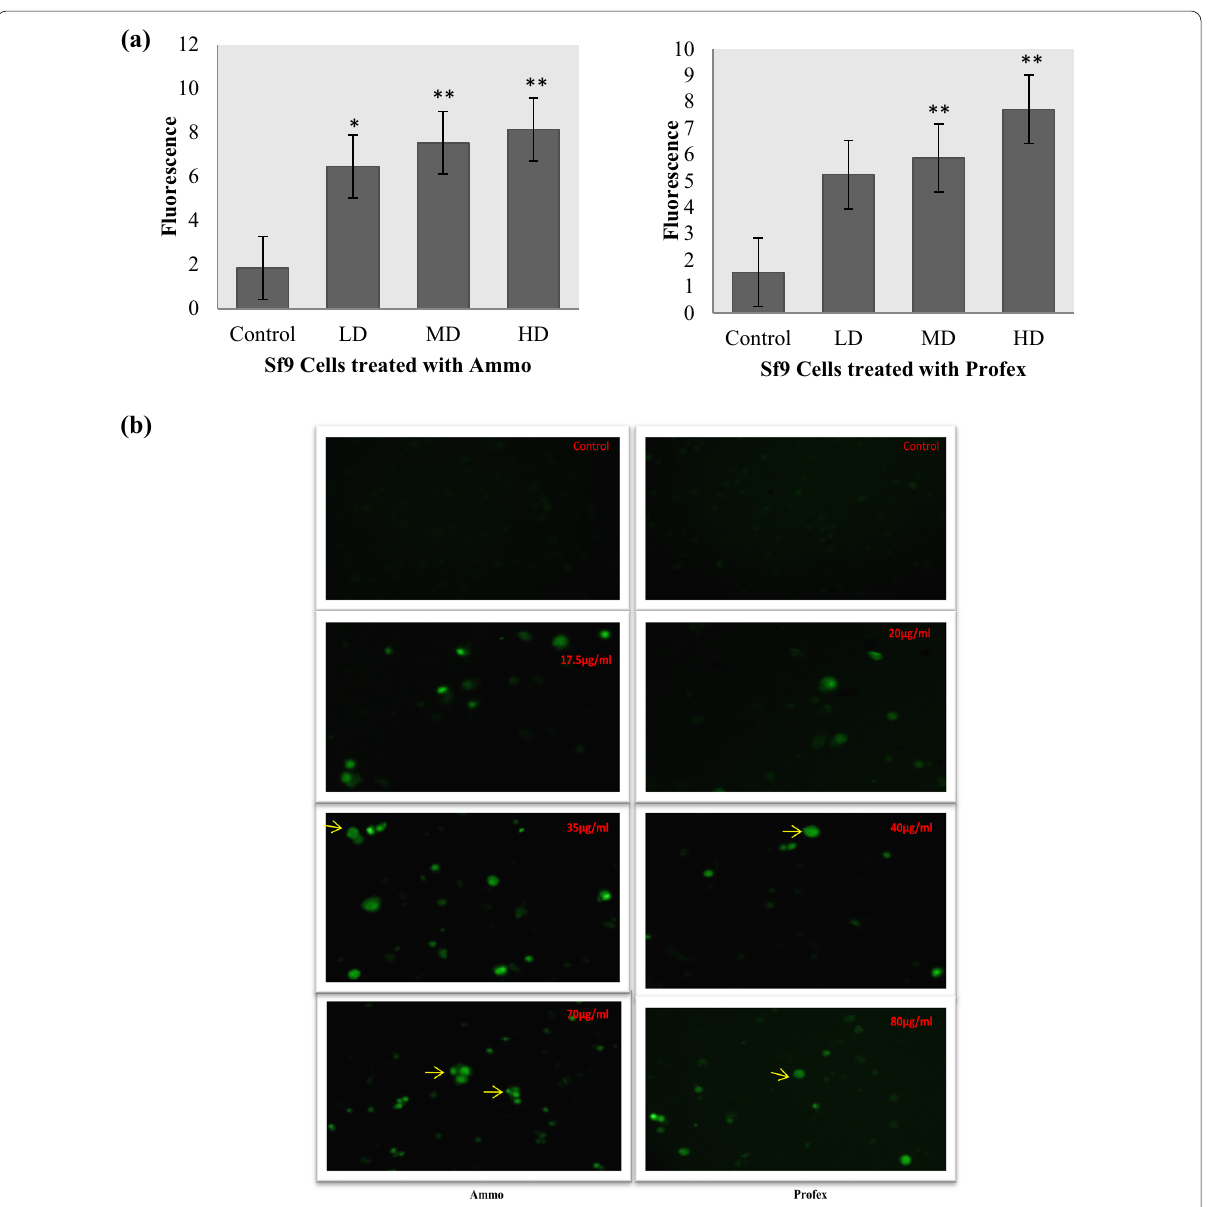
Fig. 4 Effects of sub-lethal concentrations of Ammo and Profex for the generation of ROS in Sf9 cells were determined by DCFH-DA staining. a Depicts the fluorescence (mean SE) in Sf9 cells after treatment with sub-lethal concentrations of Ammo and Profex for 48 h and stained with ± DCF-DA. ( p < 0.5*, p < 0.05**) and b show Sf9 cell treated with Ammo in an increasing concentrations of LD 17.5 μg/ml, MD 35 μg/ml and = = HD 70 μg/ml and Profex with LD 20 μg/ml, MD 40 μg/ml and HD 80 μg/ml in comparison to control. Green fluorescence represents the = = = = intracellular ROS formed. Here, the yellow arrow pointing toward bright green nucleus indicates increased ROS level, cell membrane blebbing, and nuclear